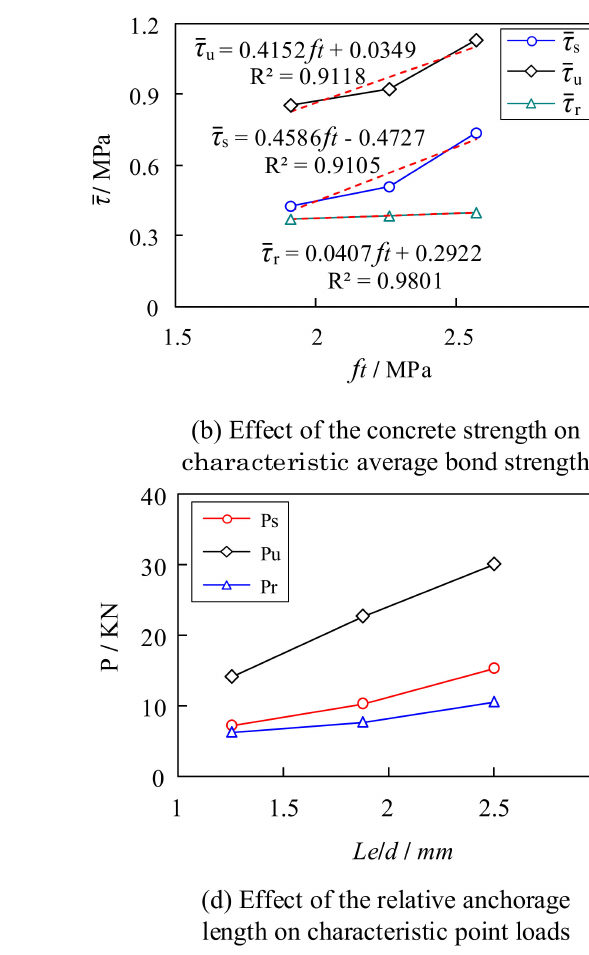
Figure 14. Regression analysis of factors influencing characteristic average bond